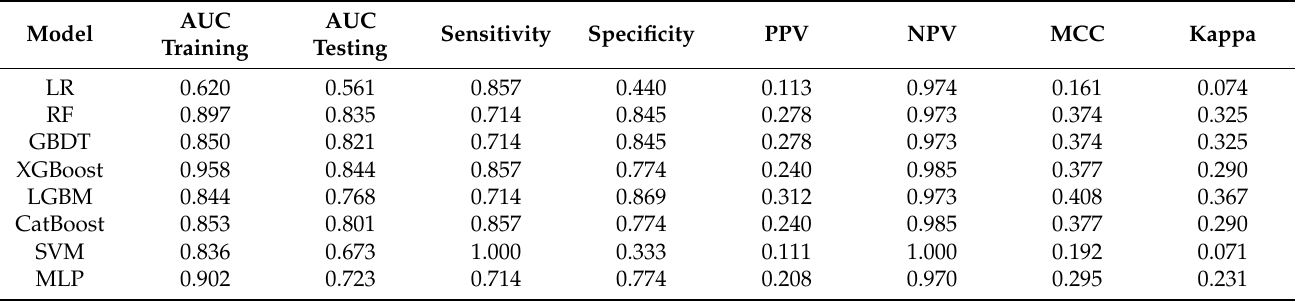
tures were maternal adnexitis before pregnancy, maternal body mass index (BMI) before pregnancy, maternal systolic blood pressure before pregnancy, maternal education level, maternal platelet count (PLT) before pregnancy, maternal blood glucose before pregnancy, maternal alanine aminotransferase (ALT) before pregnancy, maternal creatinine before